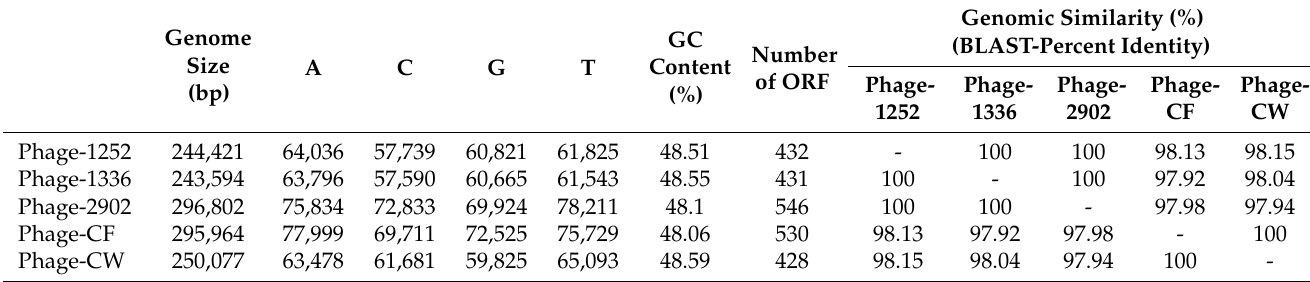
Table 3. Whole-genome sequencing was analyzed by the Average Nucleotide Identity (ANI) calcula- tor and